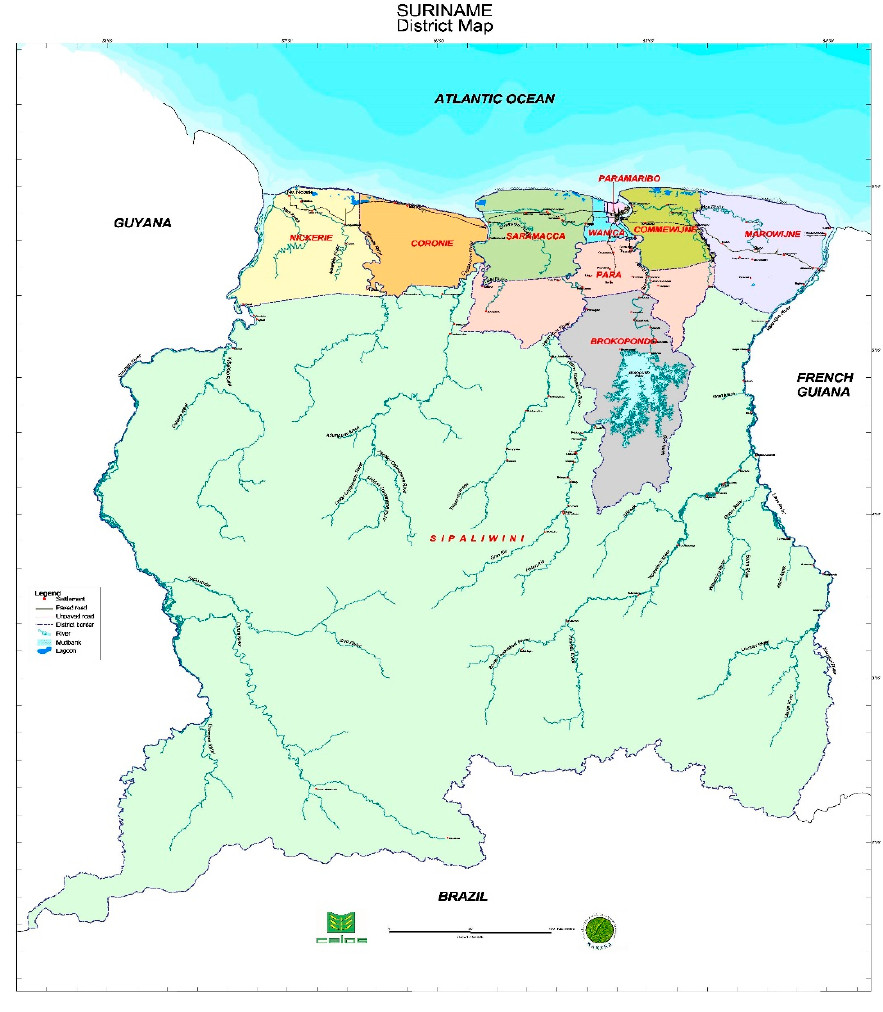
Figure 1. Map of Suriname in relation to South America’s map. Map source: CELOS Suriname.